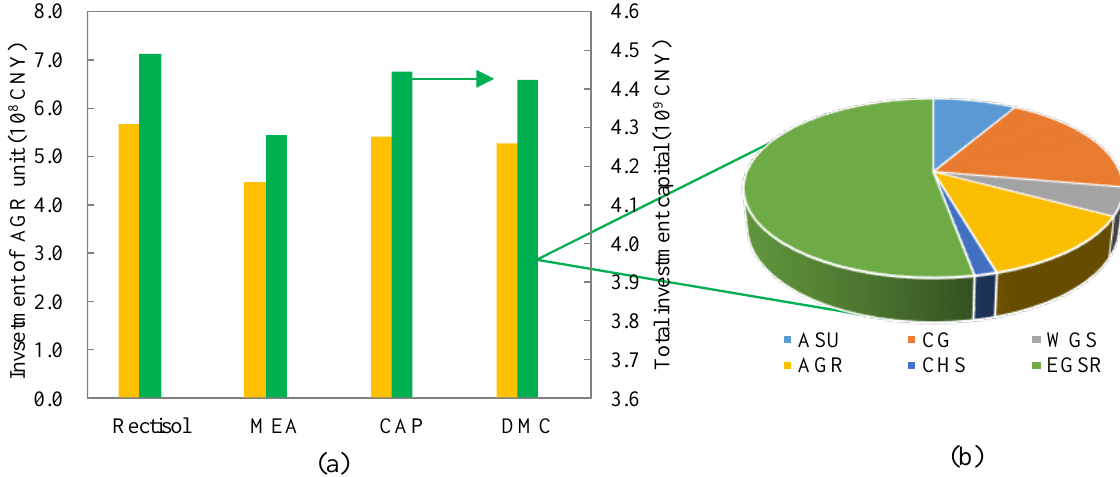
Figure 9. Total capital investment of CTEG process with different CO 2 capture technologies.